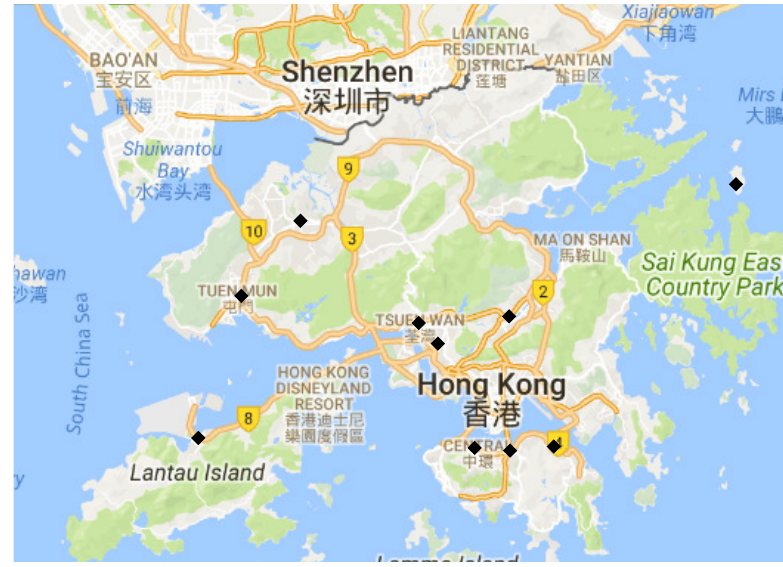
Figure 6. Placement results of 10 sensors in Hong Kong for one-with-all case.